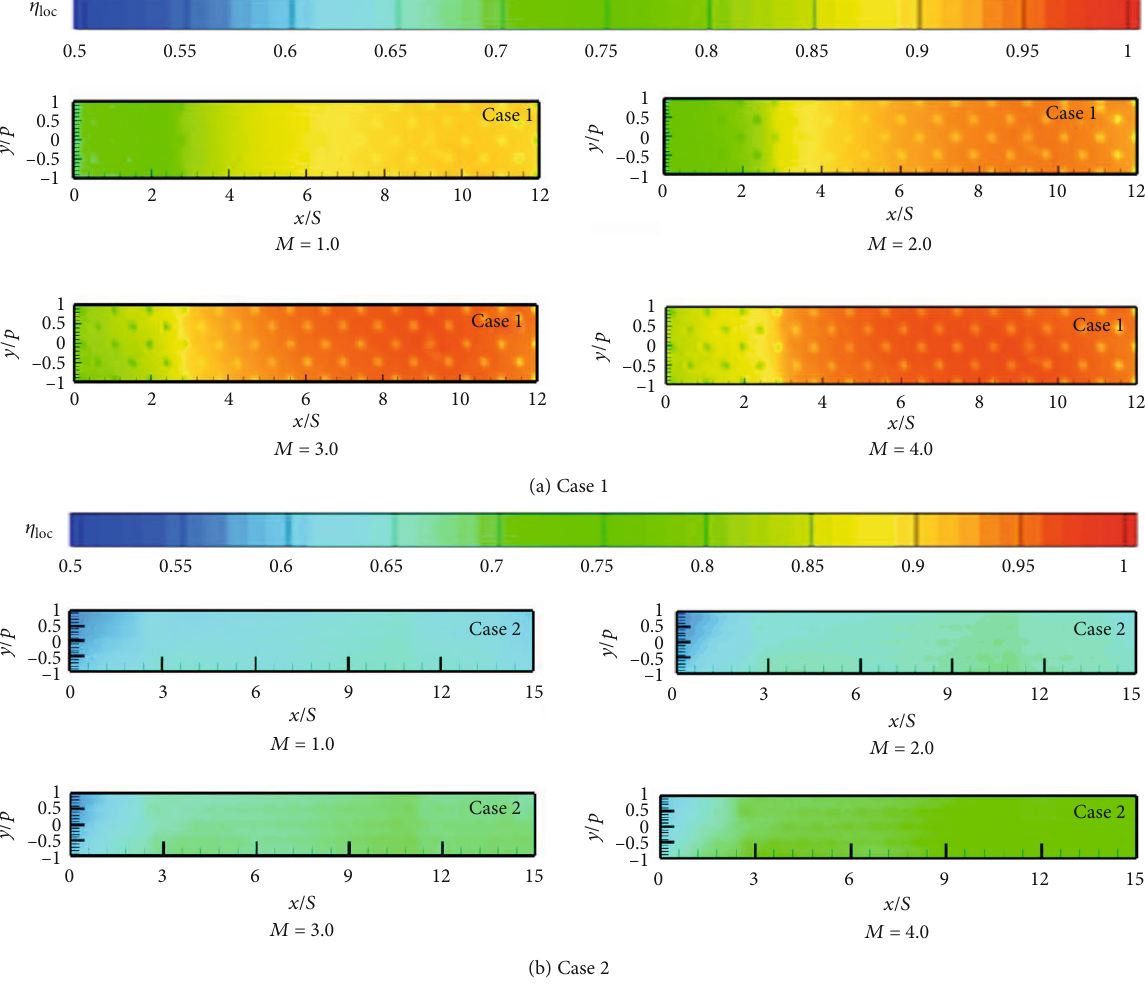
Figure 7: Distribution of cooling e ff ectiveness on the hot-side surface of the laminated con fi guration.